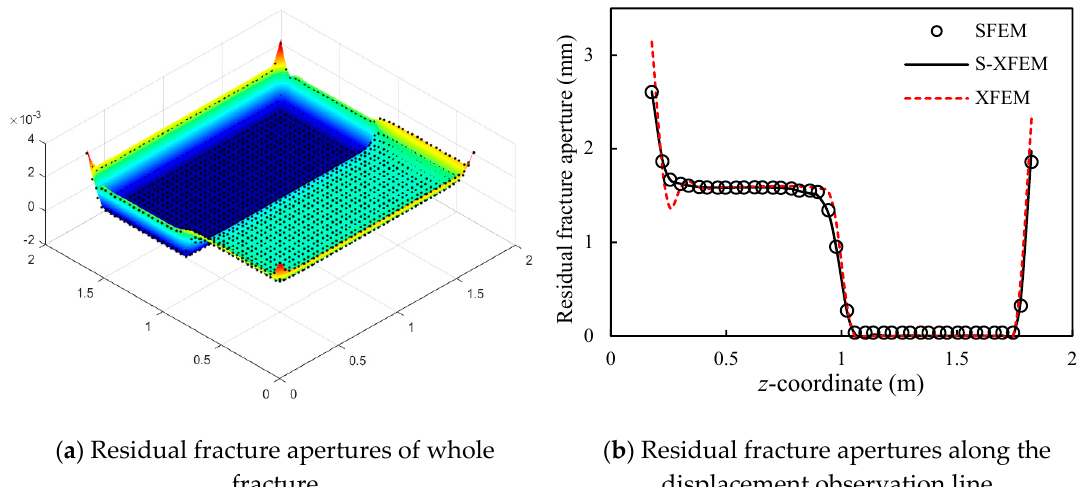
Figure 6. Comparisons of the residual fracture apertures of whole fracture and the residual fracture apertures along the displacement observation line.